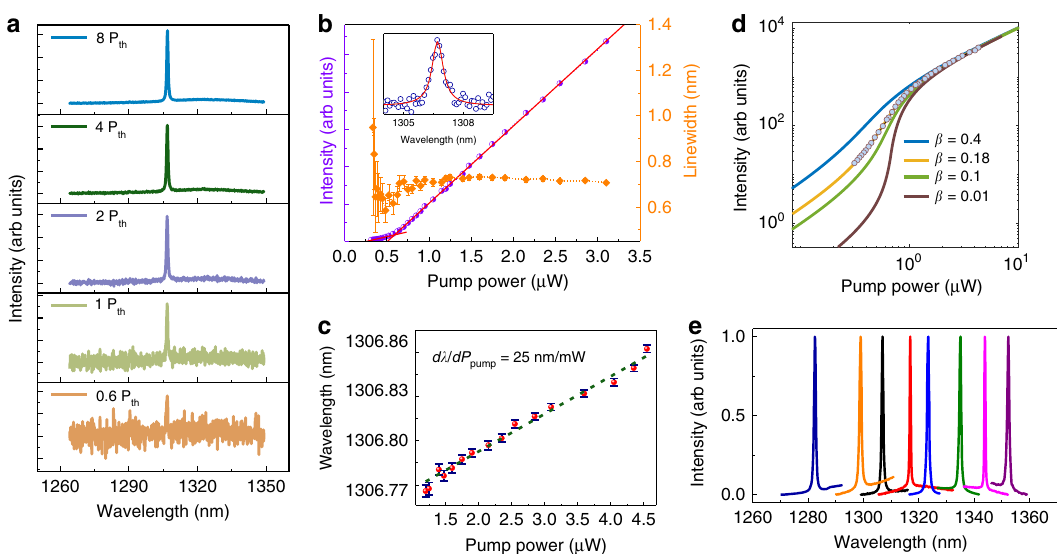
Fig. 3 Laser performance characterisation. a Measured spectra under various input pumping powers of the PC laser with a = 310 nm and r / a = 0.27, the lasing peak locates within the ground state emission. b Collected L – L curve and linewidth of the lasing peak at 1306 nm, indicating a lasing threshold 0.6 μ W. The inset shows Lorentzian curve fi tting of measured data just below the threshold, which indicates a linewidth ~0.68 nm. c The lasing wavelength under various input pumping powers. The error bars in b , c express standard errors deduced by fi tting. d Logarithmic L – L plot of the PC laser. Dots show the experimental data and the solid lines are theoretically calculated results for various values of β by using rate equation analyses. e Normalised PL spectra from representative PC lasers above lasing